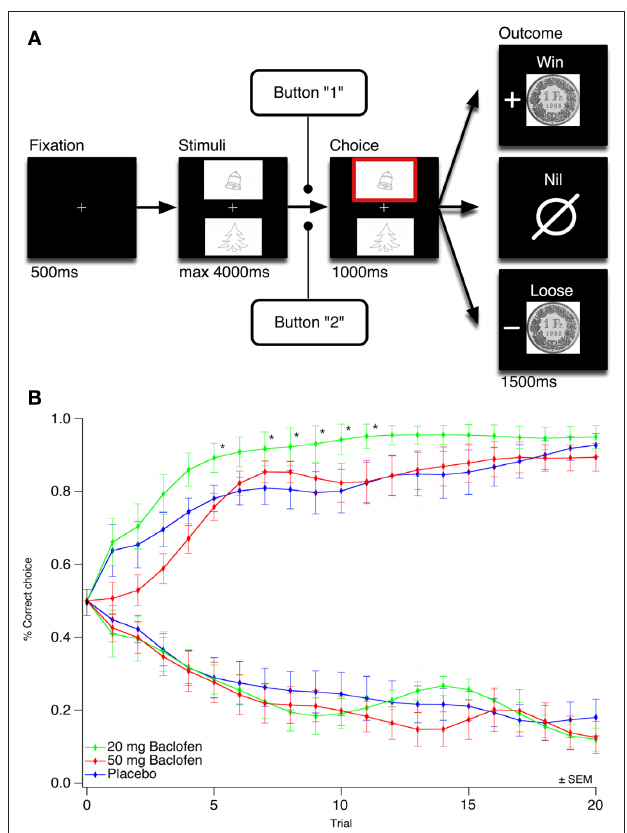
Figure 1 | A low dose of baclofen accelerates instrumental learning. (A) Schematics of the gambling task. Subjects selected either the upper or lower of two visual symbol stimuli presented on a computer screen and subsequently observed the outcome. The correct symbol of the gain pair was associated with 80% probability of winning 1 CHF, the correct symbol of the loss pair was associated with 20% of loosing 1 CHF, the neutral pair served as control. ms, Milliseconds. (B) Observed mean of behavioral choices over three concomitant sessions of 20 trials per condition (gain and loss pair) for the 20-mg baclofen, 50 mg baclofen and control group. The learning curves show the proportion of correct choices for each trial (1 means correct symbol choosing for the gain pair, 0 means correct symbol choosing for the loss pair). Trial per trial comparison between the 20-mg baclofen and the control group showed statistical significance for trial 5, 7, 8, 9, 10, and 11 (* p < 0.05). Trial points were smoothed starting from trial 1 using Gaussian algorithm. Neutral condition data not shown. ± SEM means standard error of